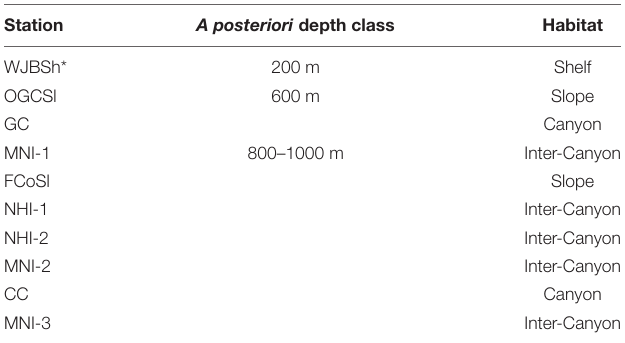
Classification derived from significant differences (PERMANOVA, p < 0.05) in terms of macrofaunal community composition. * was removed from the analysis comparing habitats as the only station in the 200 m depth class as well as in shelf